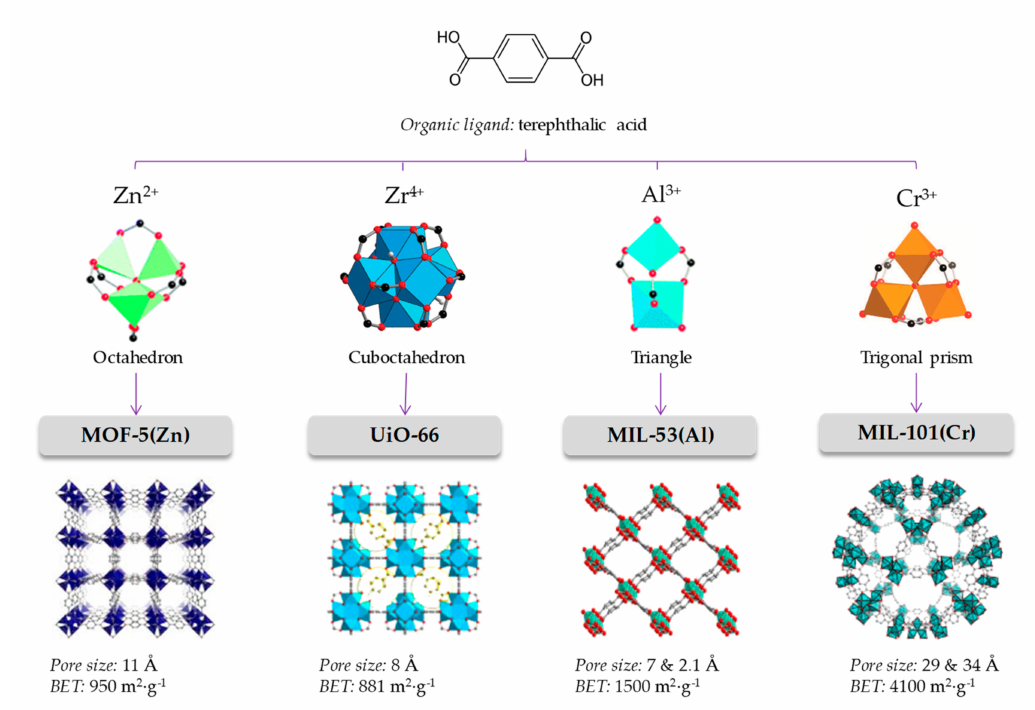
Figure 1. The node-and-connector approach to prepare MOFs. The adequate selection of the organic linker (linear in the case of terephthalic acid) and connection geometry of the metal cluster lead to the desired topology. Each framework topology has its characteristic pore size and available